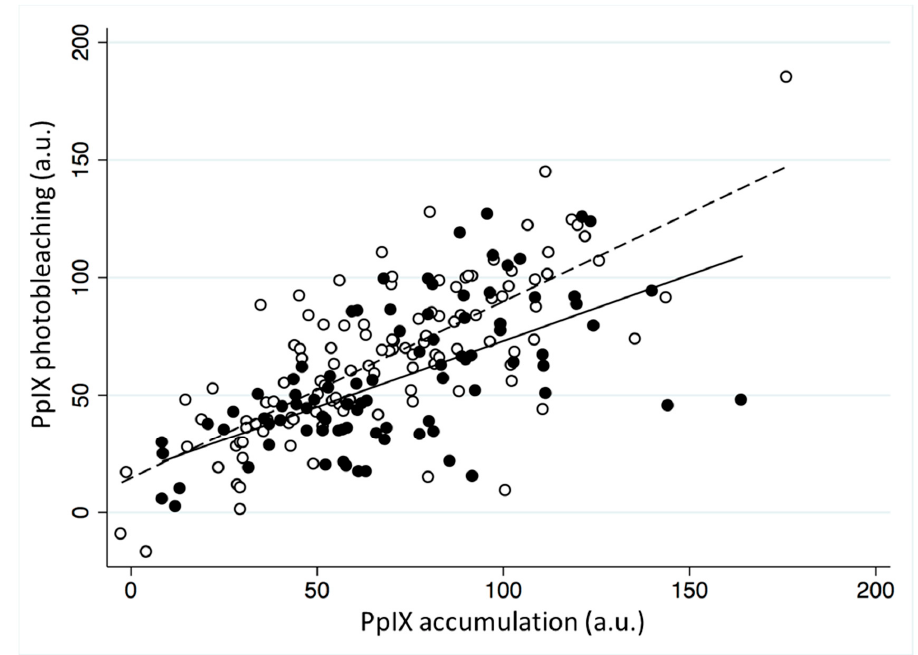
Figure 5. The effect of using air cooling pain relief on the correlation between mean PpIX accumulation (a.u.) and mean PpIX photobleaching (a.u.) during MAL-PDT of AK, sBCC and BD. Black dots represent the pain relief users, with the solid black line representing the line of best fit for pain relief users and the white dots represent no pain relief, with the dashed line representing the line of best fit for no pain relief. The regression coefficients from these models differ ( p < 0.05).